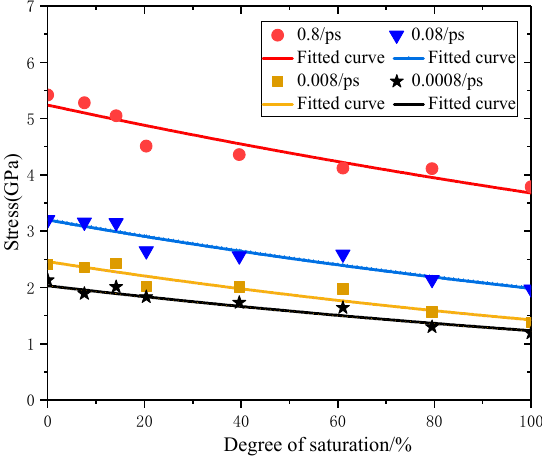
d under di ff erent strain f under different strain rates. Figure 7. Fitted parameters f d P , S r P S r